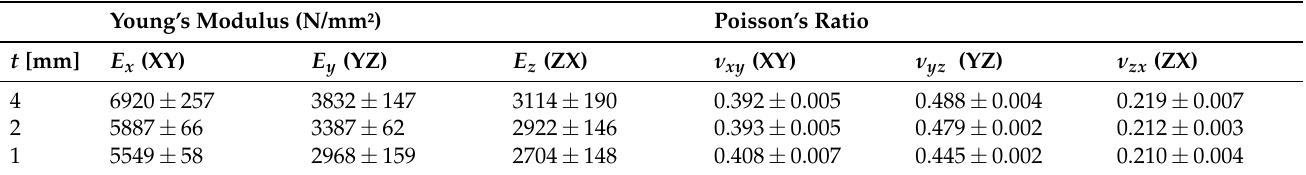
Table 1. Material parameters determined in the tensile tests given as mean ± standard deviation. Young’s Modulus (N/mm²) Poisson’s